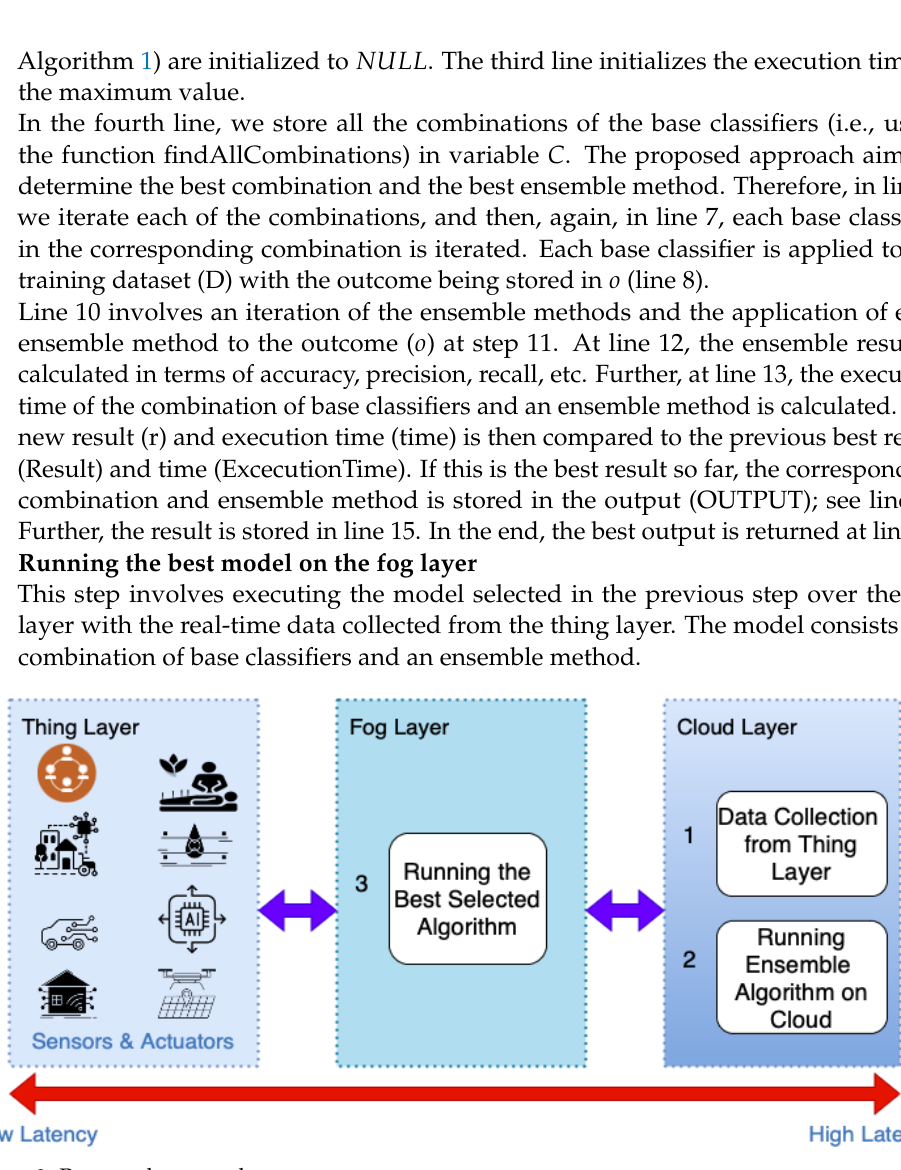
Figure 2. Proposed approach.